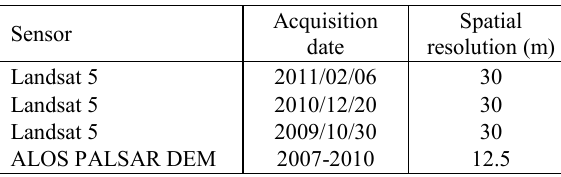
Table 1. Data used in this study.